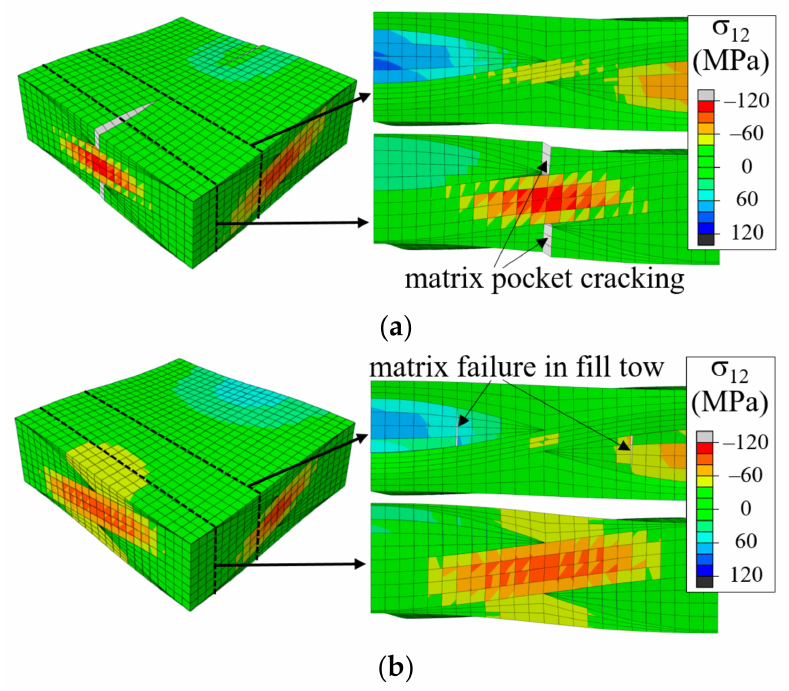
Figure 22. Comparison of failure development of in-phase unit cell with warp-fill separation at ˆ ε xx = 0.009: ( a ) WFS3; and ( b ) WFS2 (deformation scale factor =